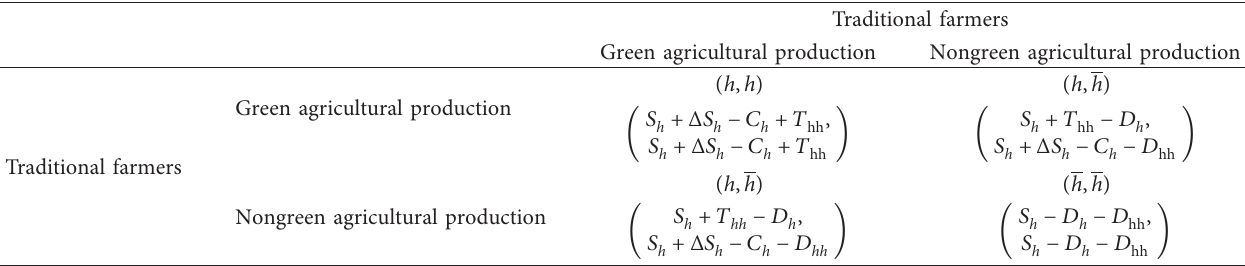
Table 2: The pairwise game matrix among traditional farmers under the market mechanism.